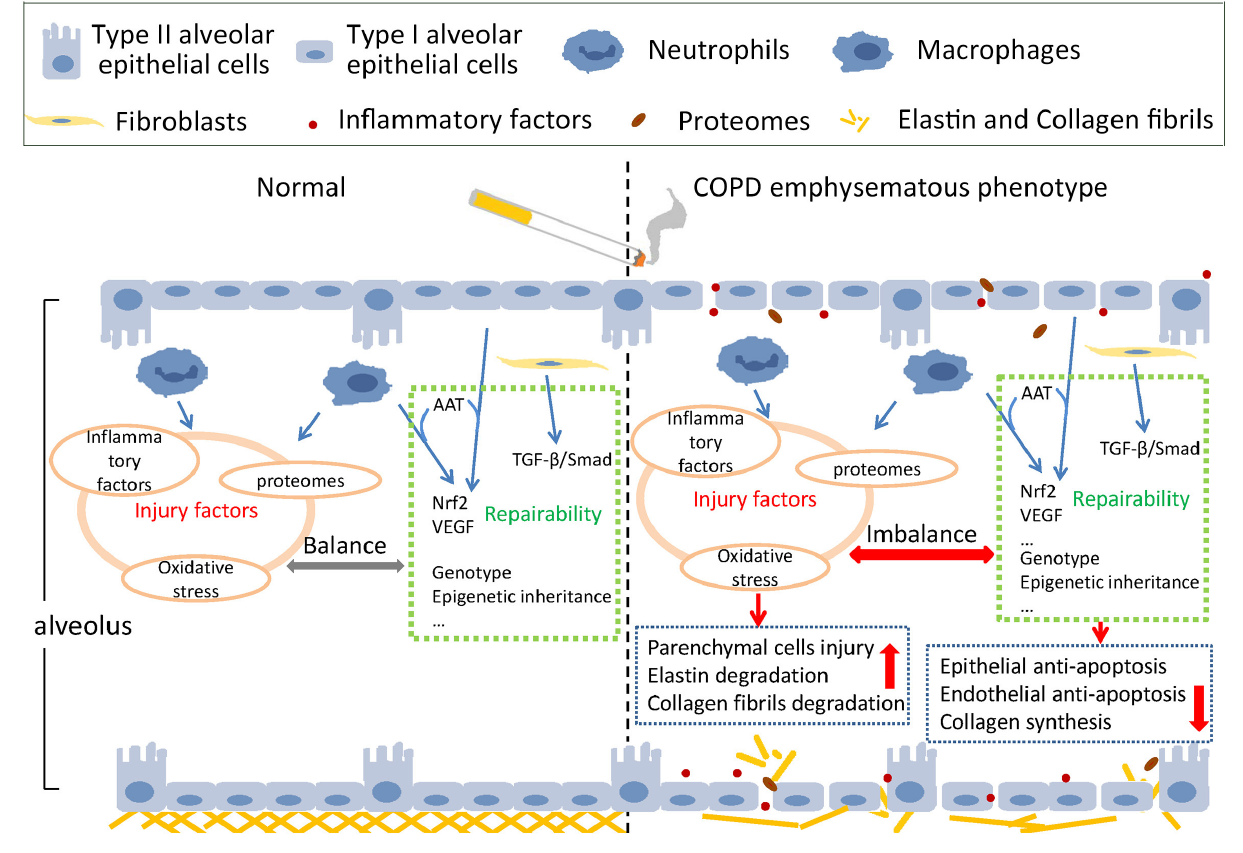
FIGURE 1 | Schematic injury and defense imbalance in the COPD emphysematous phenotype. Cigarette smoke exposure induces injury enhancement and absence of defense repairability through various mechanisms and pathways, resulting in the destruction of alveolar structure and the development of emphysematous phenotype of chronic obstructive pulmonary